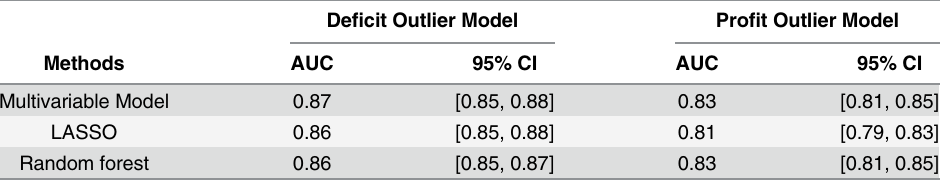
Table 7. Prognostic accuracy of the multivariate regression model and the two variable selection models for the predictors of deficit and profit cases. Outliers were selected with the IQR method. Results are given as area under the curve (AUC) for a receiver operating characteristic (ROC) curve and the corre- sponding 95% confidence interval (CI) (n = 8,892, test